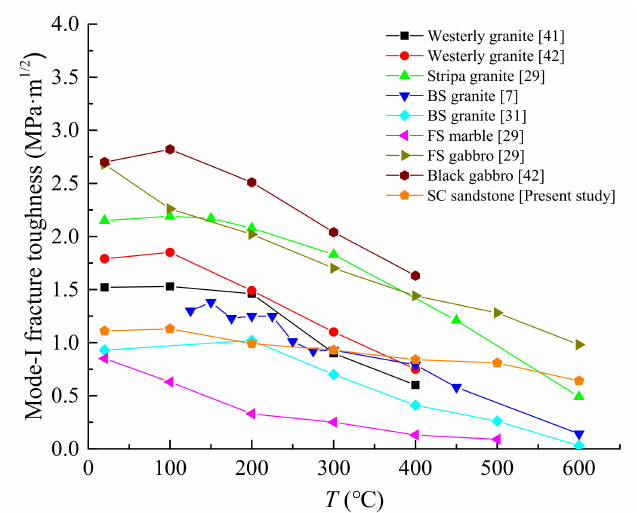
Figure 11. Variation in rock tensile strength with